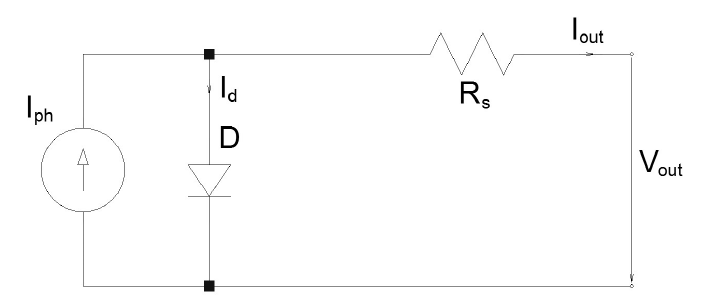
Figure 6. Equivalent circuit of advanced or practical PV simulation model. As mentioned above, in order to simulate an entire PV panel, we can obtain param- eters, such as V oc,ref , I sc,ref , T ref , λ ref , K V , K I , N s and N p , from the data sheets and specifications of PV manufacturers. However, due to the curved shape of the roof, it is not advisable to use the factors N s and N p for simulating PV cells integrated into curved surfaces. Instead, it is advisable to simulate each PV cell individually with the given environmental condi- tions for each cell [33]. 3.2.5. Used Simulation Model in this Research In this work, we used the advanced or practical model to obtain the best possible accuracy within simulations. The model was extended, as described in Section 4, to take into consideration different alignments of PV cells towards the sun and the cardinal di- rection of the vehicle. Furthermore, the model was used to calculate the V mpp , I mpp and P mpp under different solar radiation levels and V oc , V out and I out within MPPT simulations in Sec- tion 5. 4. Environmental Conditions for PV-Power Electric Vehicles 4.1. Parking Conditions If electric vehicles with integrated photovoltaics are parked in urban areas, then the conditions are somewhat comparable to PV-powered charging stations. However, a